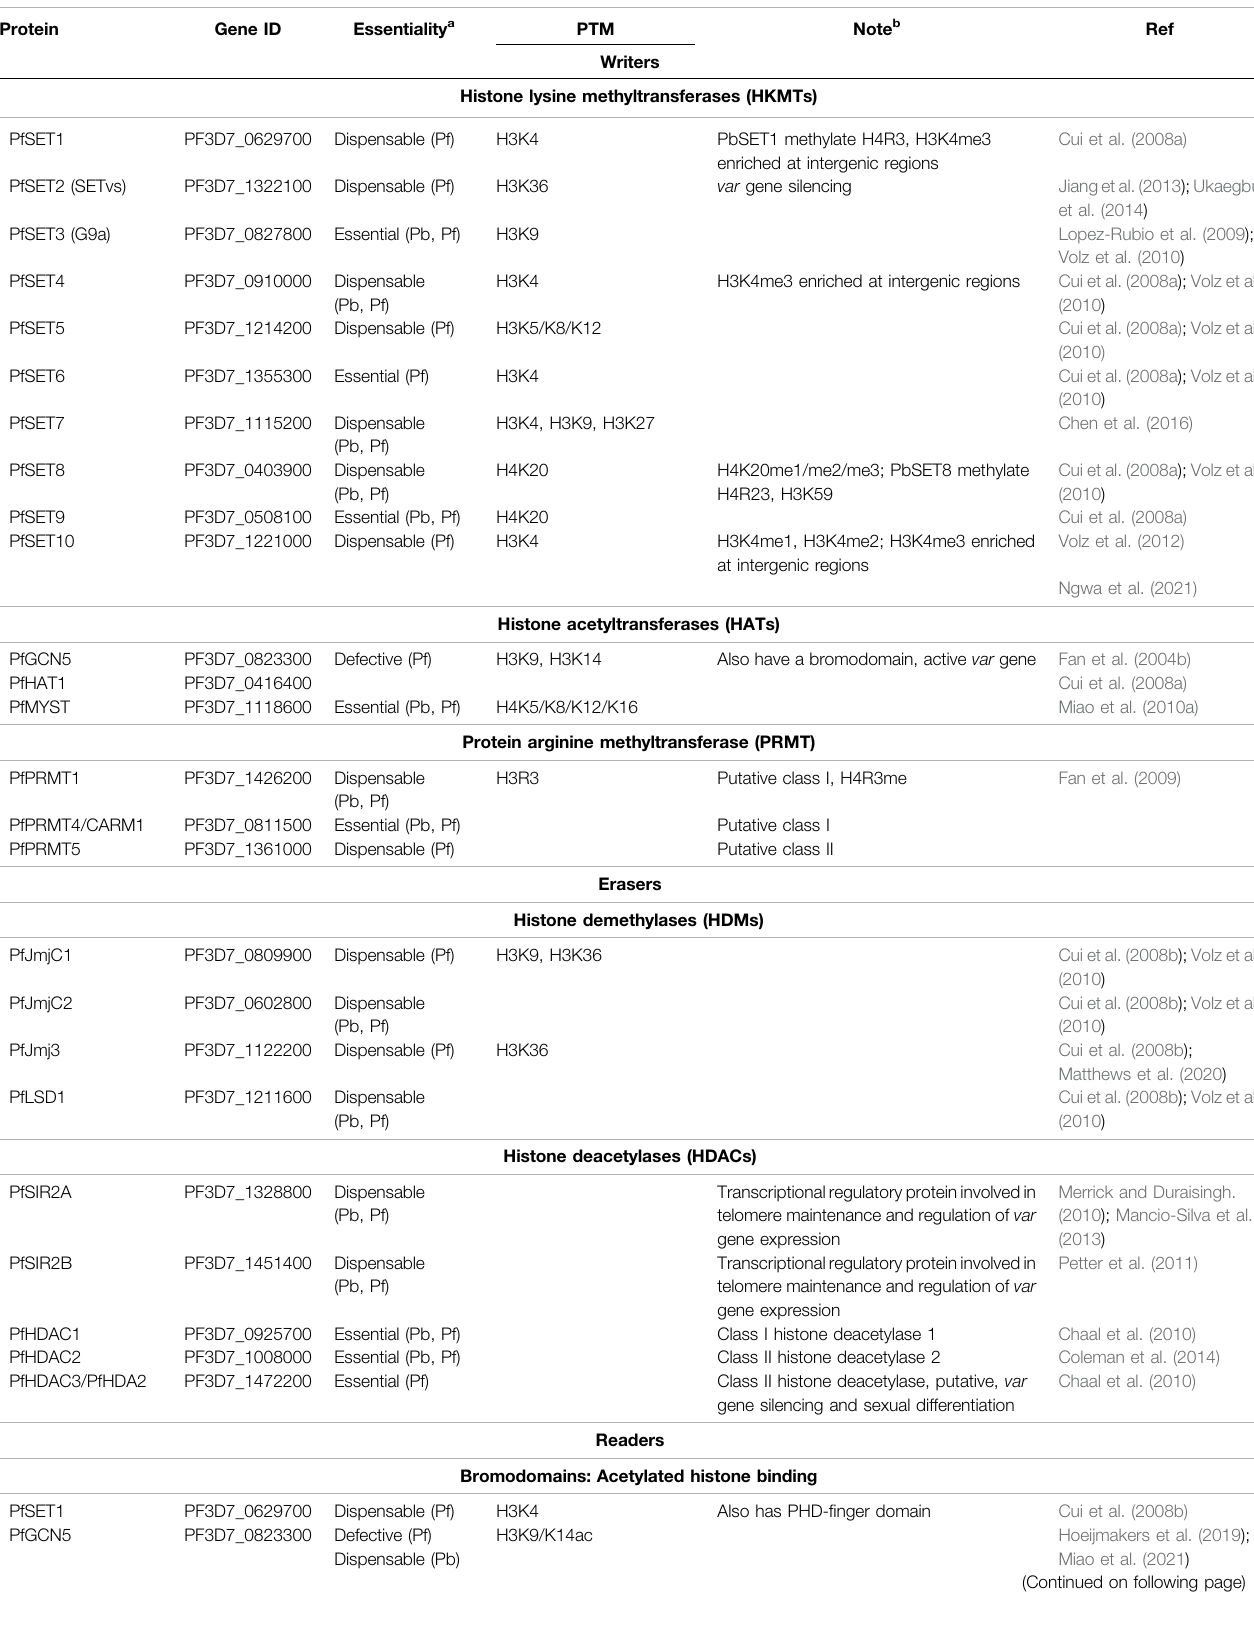
TABLE 1 | Catalogue of certain classes of chromatin-associated proteins in P. falciparum .